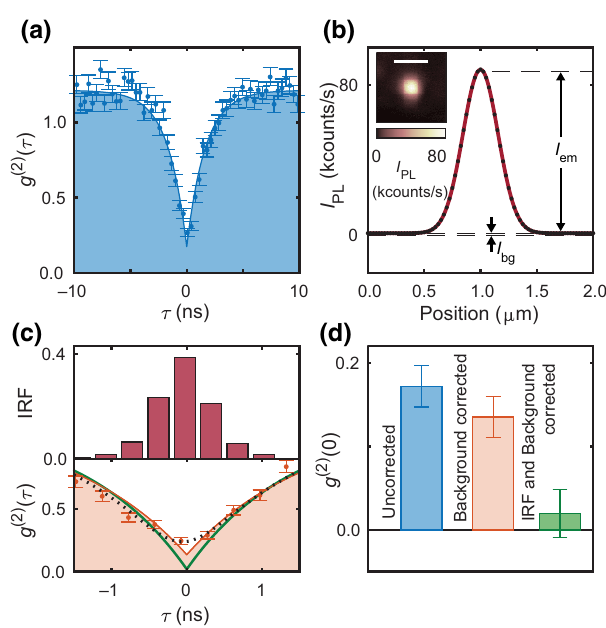
FIG. 3. Background and timing-jitter correction to verify single-photon emission in hexagonal boron nitride ( h -BN). (a) The raw photon-emission-statistics data from an emitter in h -BN. (b) The transverse intensity trace across the y cross section of the PL scan in inset taken at the focus plane. The white scale bar in the inset shows 1 μ m. The signal ( I em ) and background ( I bg ) are denoted by arrows and are extracted from the fit. (c) (lower panel) The background-corrected data and fit (orange) and the extracted g ( 2 ) (τ) after background and timing-jitter correction (green). Convolution of the fully corrected data with the mea- sured instrument response function (upper panel) gives the black dotted line. (d) The value of g ( 2 ) ( 0 ) from the fit before correc- tions (blue), after background correction only (orange) and after background and timing-jitter correction (green). The uncertain- ties in g ( 2 ) ( 0 ) are 68% confidence intervals propagated from the corresponding best